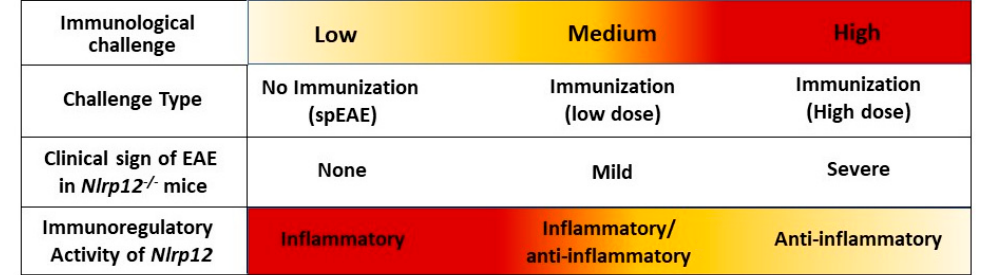
Figure 11. Dual immunoregulatory function of Nlrp12 in EAE. The severity of immunological challenge, ranging from low to high, can influence the regulatory function of Nlrp12 in EAE. In this model, when there is no MOG/CFA immunization, myelin-specific T cells face a low level of challenge. In this case, Nlrp12 plays an inflammatory role, which explains why WT 2D2 mice